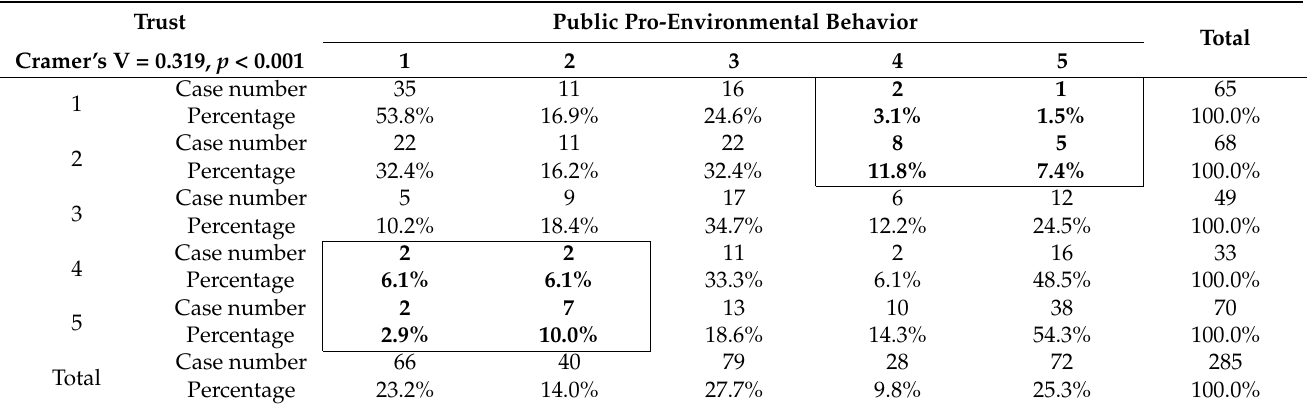
Table 14. Cross-contingency table of trust and public pro-environmental behavior.